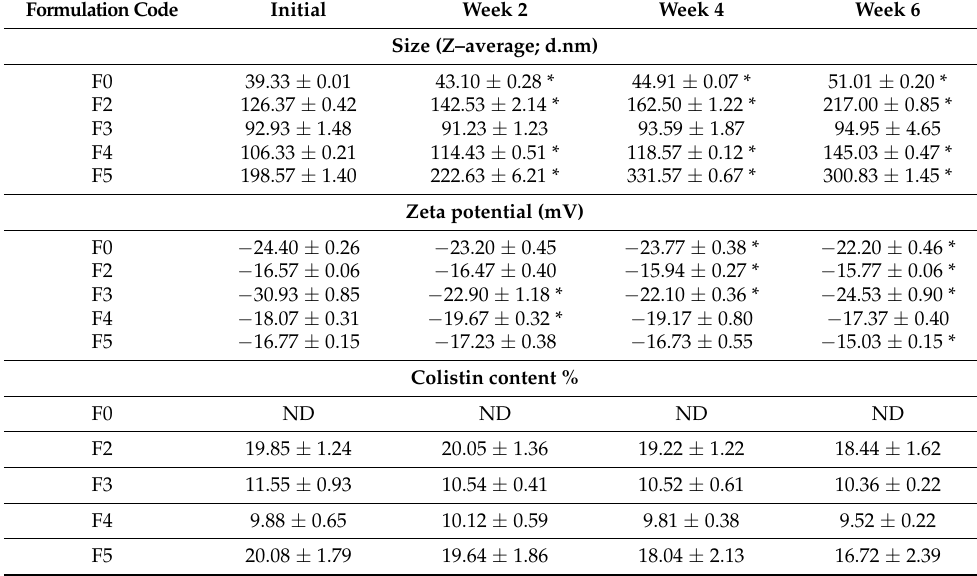
Table 1. Particle size, zeta potential, and colistin content of AgNPs (F0) and Col-AgNPs (F2–F5). The results after storage at 4 ◦ C for 6 weeks were determined, and they were expressed in mean ± SD; n = 3. Formulation Code